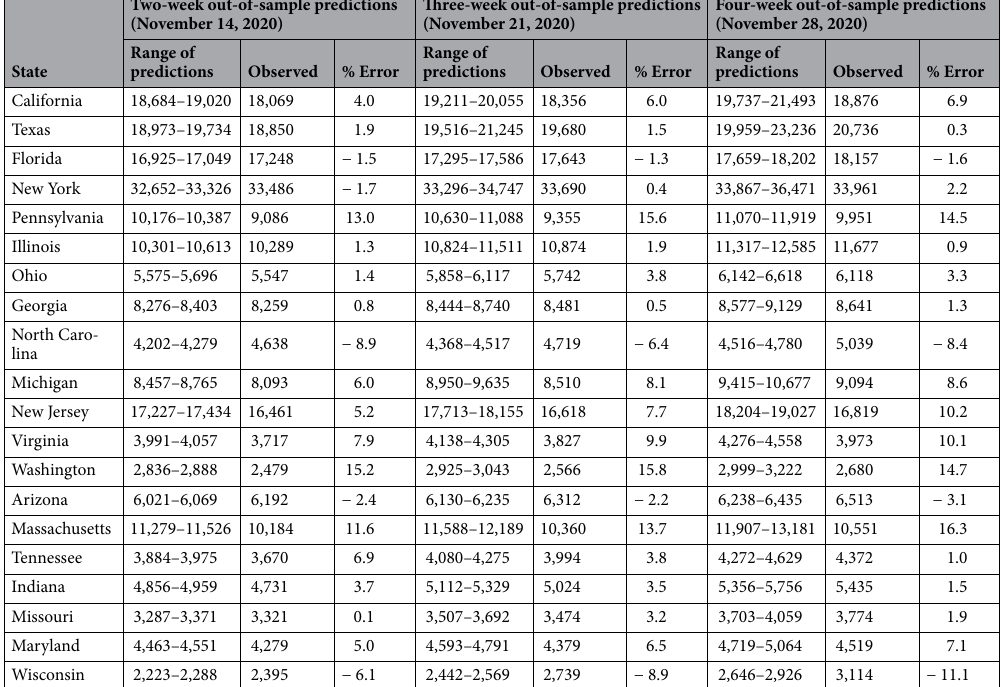
Table 5. Model performance for two-, three-, and four-week out-of-sample predictions of the cumulative COVID-19 deaths in the top 20 populous